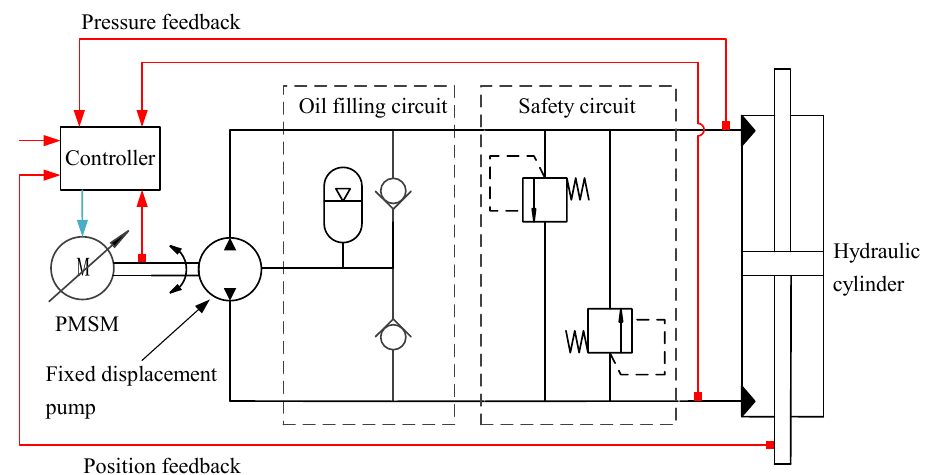
Figure 1. Hydraulic circuit of electro-hydraulic servo pump control system (EHSPCS).